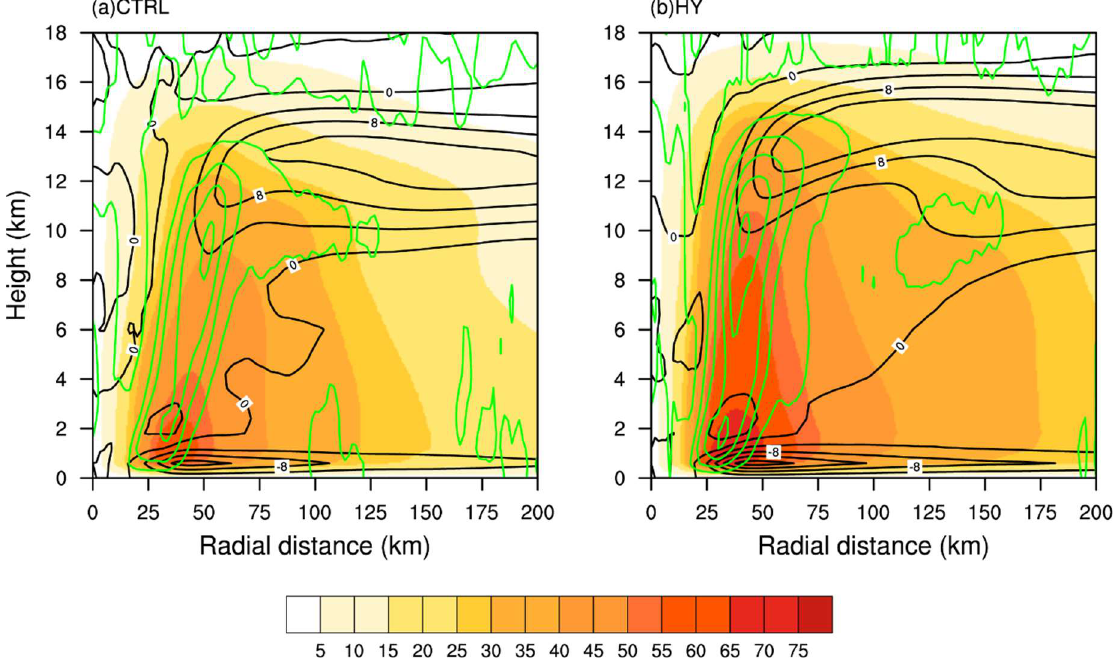
Figure 2. Height–radius cross-sections of the azimuthal mean tangential winds (color shaded, m s −1 ), radial winds (black contours, m s − 1 ), and vertical winds (green contours, m s − 1 ) for ( a ) the nonhydrostatic core (CTRL) and ( b ) hydrostatic core (HY) averaged between 84 h and 96 h. The vertical motion is shown with intervals of 0.4 m s − 1 , and the outmost contour is 0 m s − 1